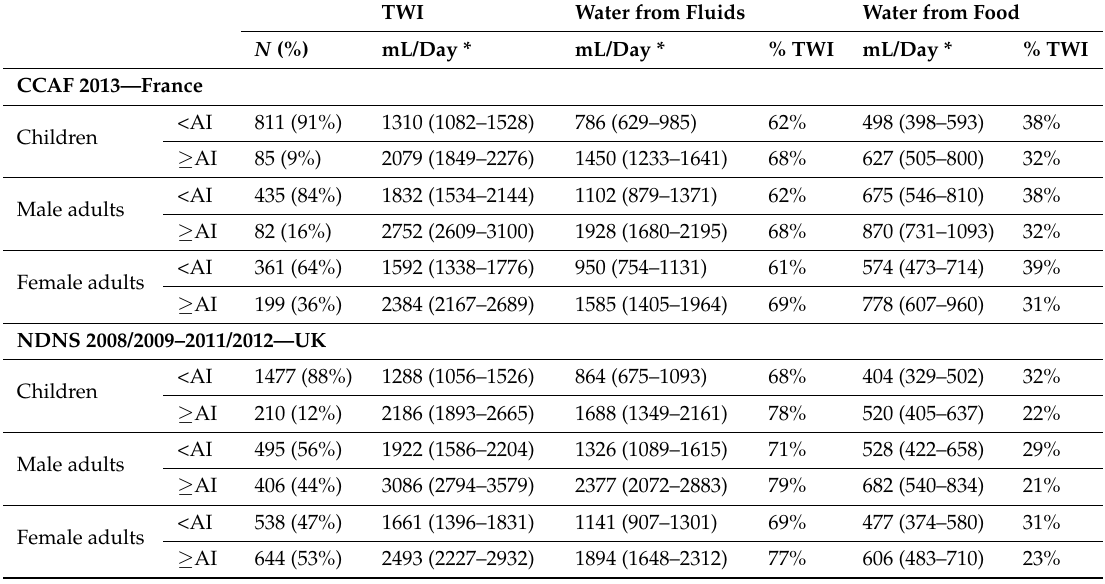
Table 4. Contribution of water from food moisture and water from fluids to total water intake of children (3–18 years), male and female adults ( ≥ 19 years) in France and UK according to intakes above or below the EFSA adequate intake (AI) of total water